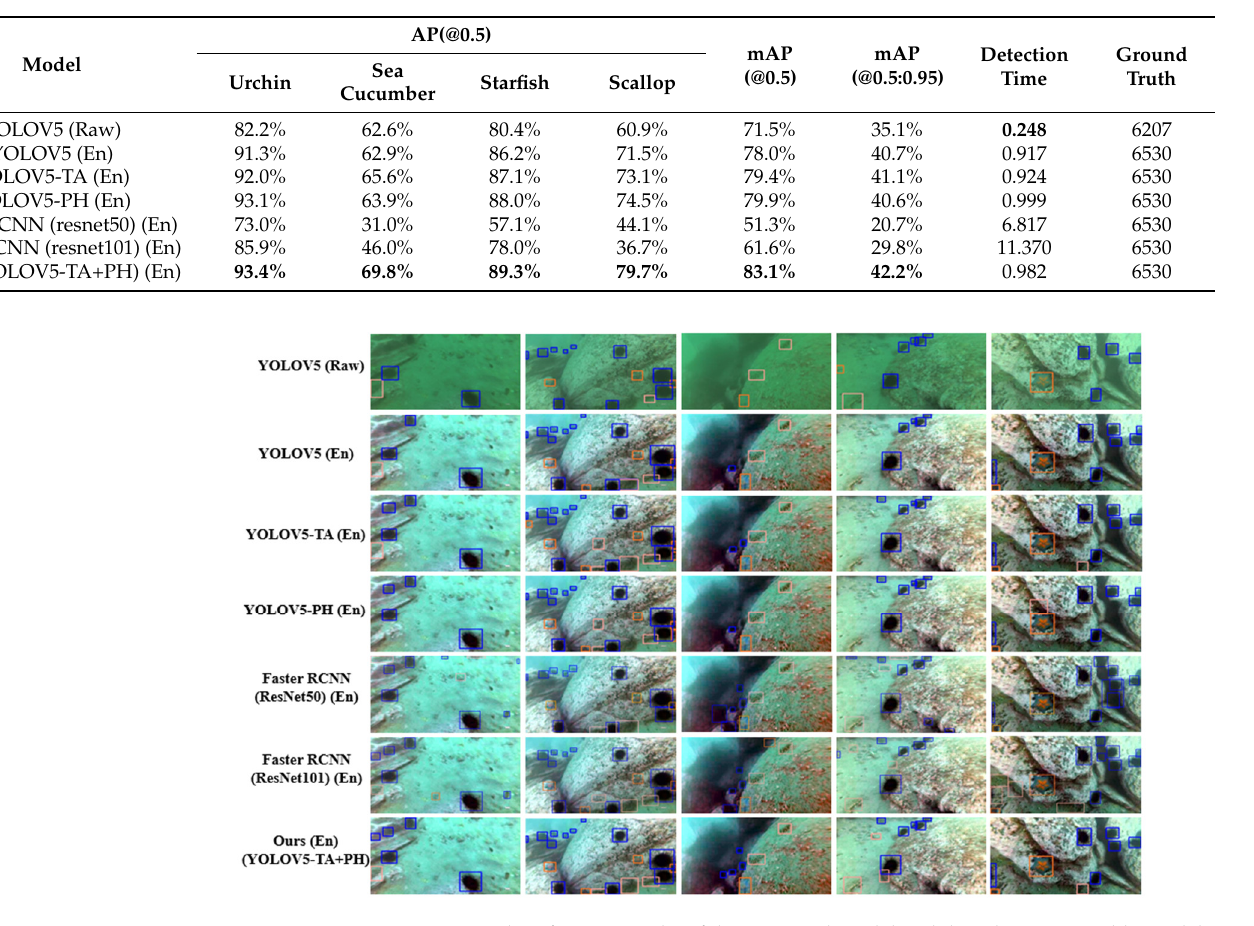
Figure 9. Marine organism identification results of the proposed model and the other comparable